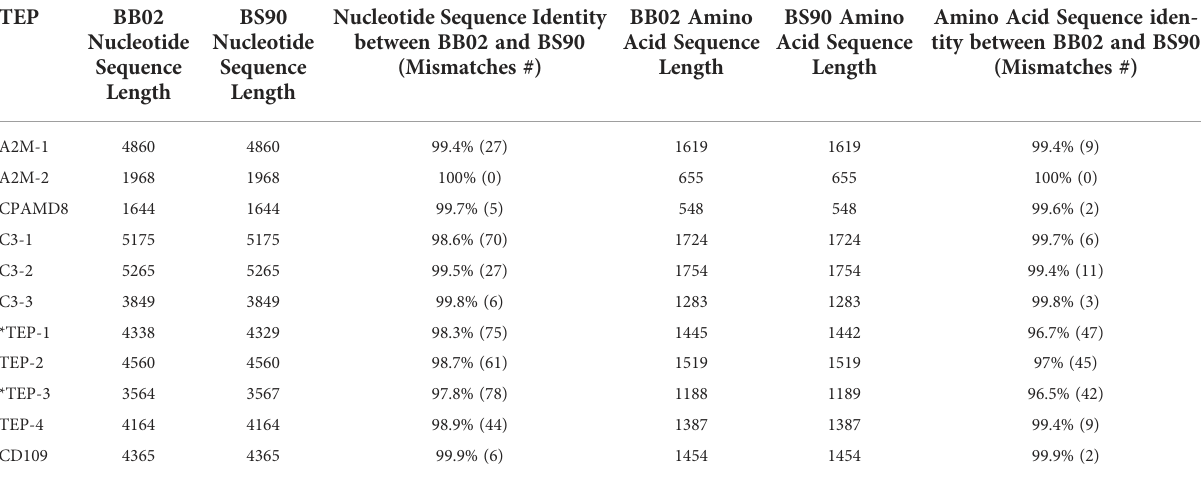
TABLE 2 BB02 and BS90 sequence lengths and